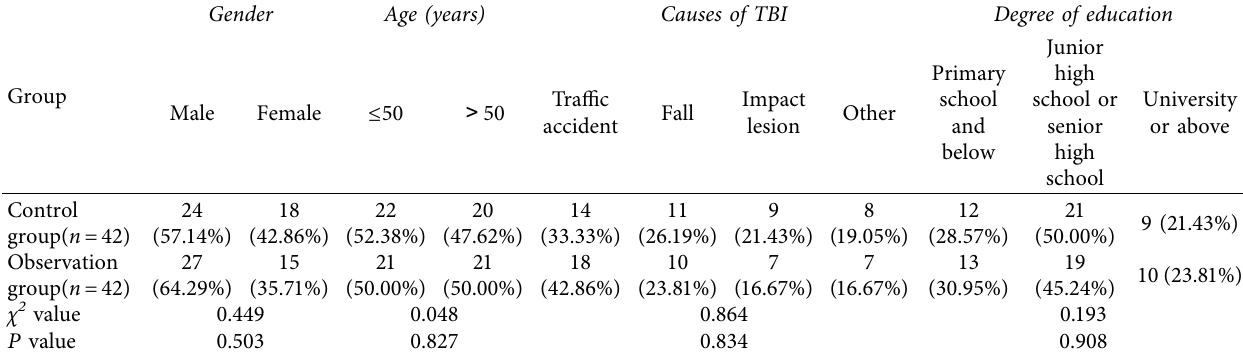
Table 1: Comparison of clinical data between two groups